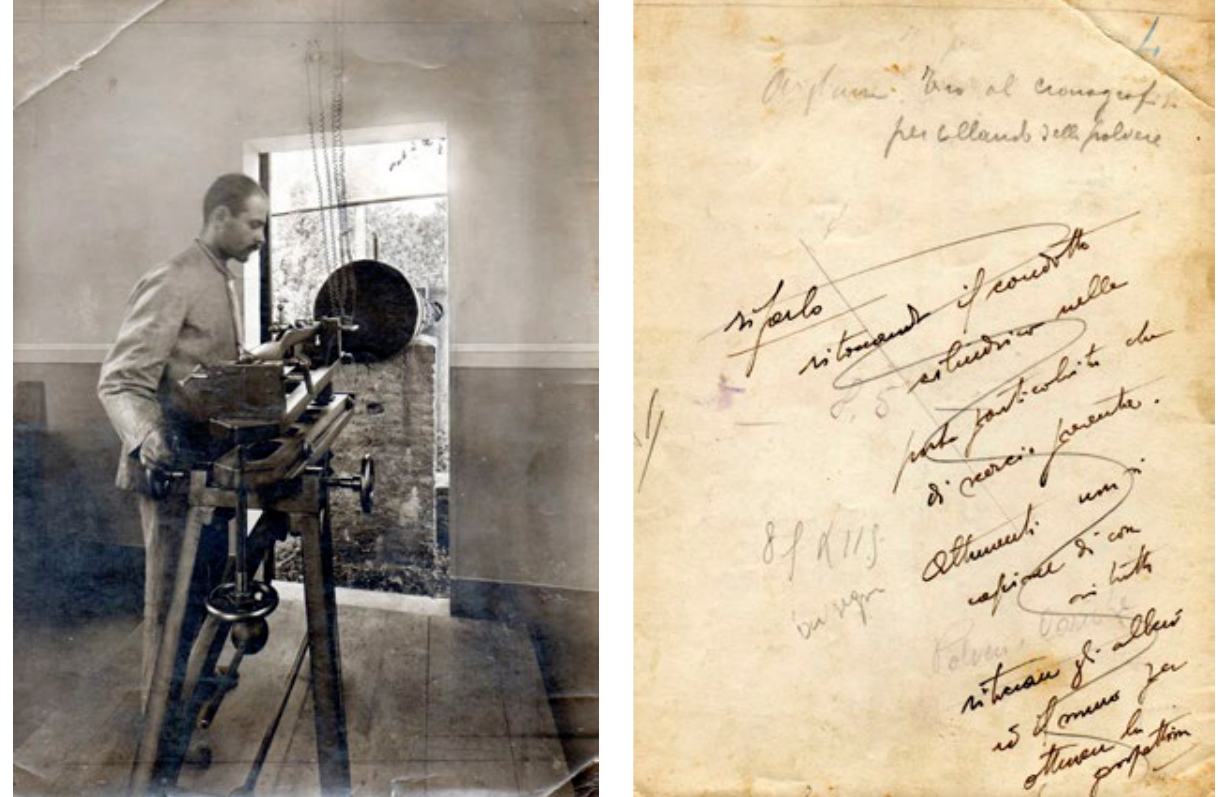
Figure 2. Verso and recto of a photo portrait of a worker engaged in the test of the gunpowder. By courtesy of Ermis Gamba.